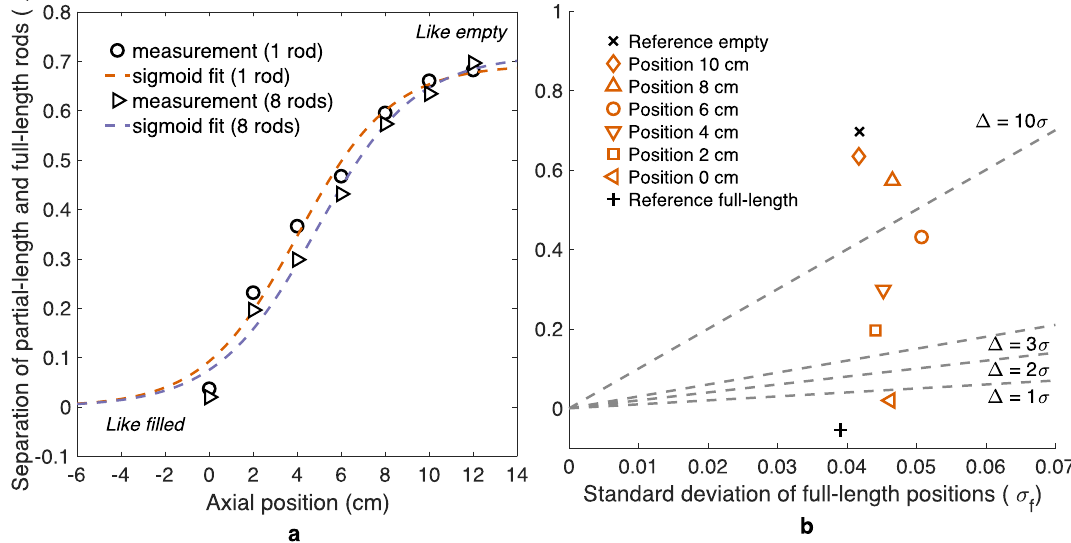
Figure 2. Partial-length rod edge scan results for an ATRIUM 10 assembly (BU 44.3 GWd/tU, CT 13.2 a). ( a ) The difference in average activity between partial- and full-length rods versus axial position of the PGET device, while sweeping across the partial-length rod edge. The axial position is relative to the lowest measurement position. Sigmoid curves are fitted to the data. Data and fits are shown for a case with all 8 partial-length rods included as well as for a case with only one partial-length rod. ( b ) Image quality index plot for the axial sweep over the partial-length rod edge for the same assembly as in ( a ). Black markers denote reference measurements conducted at positions where the partial-length fuel rods are fully visible (“Reference full-length”) and where they are completely out of view (“Reference empty”). Orange markers denote the six different axial positions where scans were made. Acceptance criteria in terms of constant �/σ f are marked with dashed